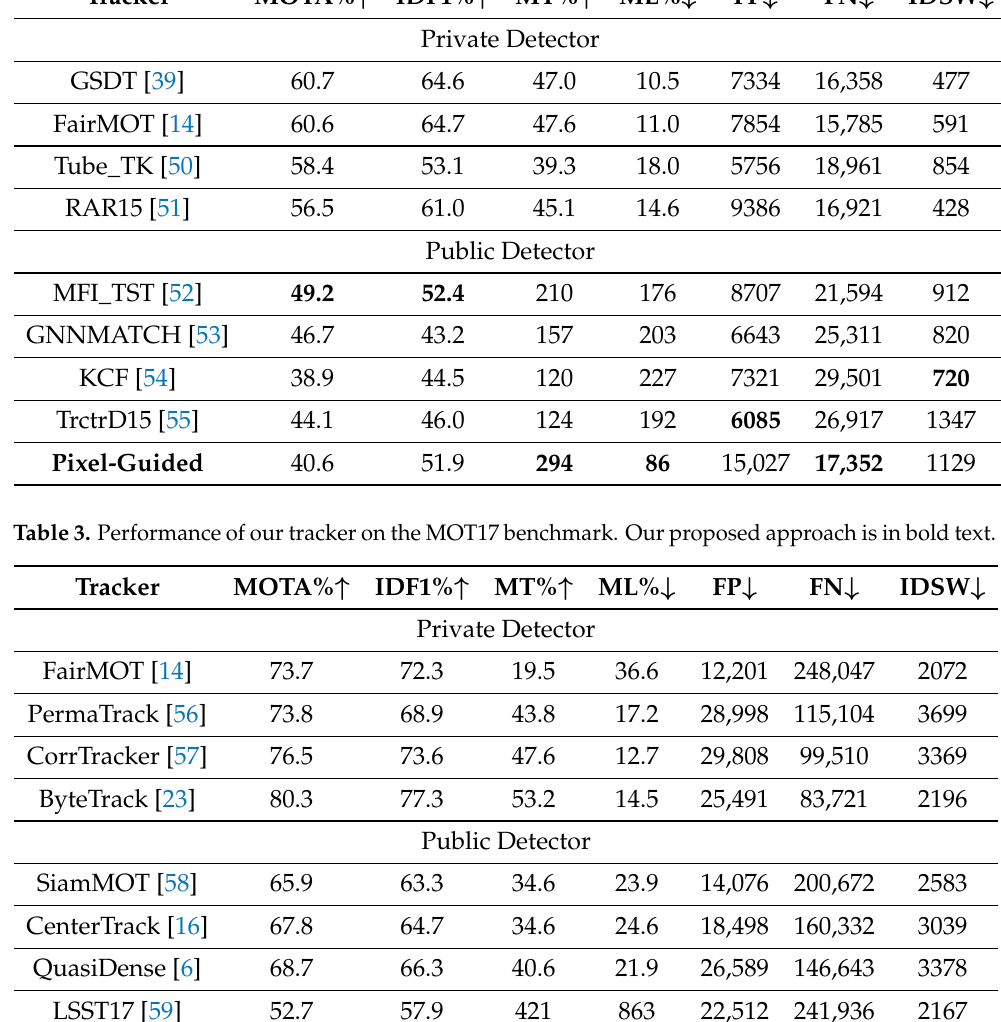
Table 2. Performance of our tracker on the MOT15 benchmark. Our proposed approach is in bold text. Tracker